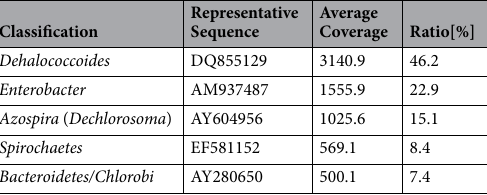
Table 1. Population of representative bacteria constituting the original